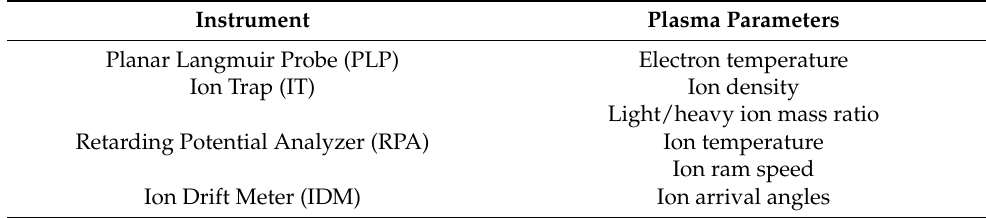
Table 5. CIP built-in observation modes and corresponding plasma